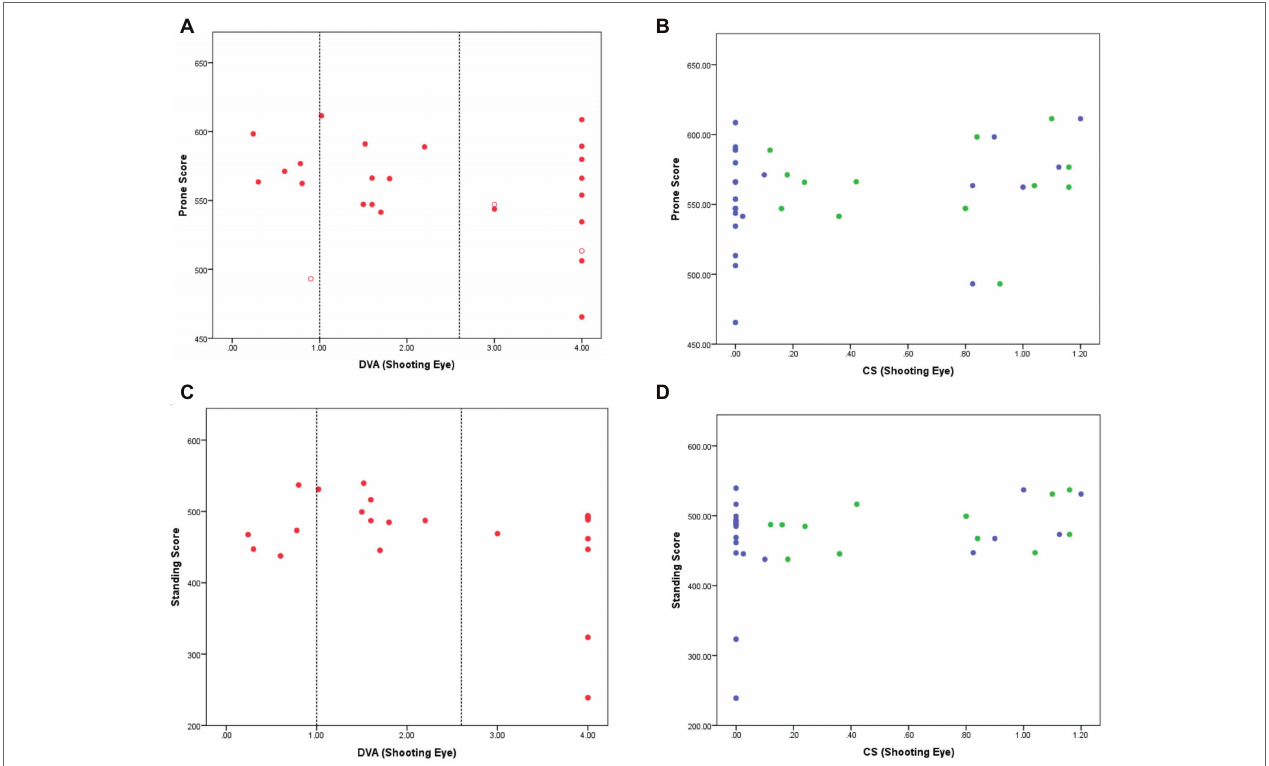
FIGURE 1 | (A–D) Shooting score in the prone (A,B) and standing (C,D) competitions are shown as a function of distance VA ( A and C ; red) and CS ( B and D ; green for Pelli Robson test and blue for Mars test) of the shooting eye. Closed symbols indicate athletes who shot in both prone and standing competitions. Open symbols indicate athletes who shot in the prone competition only. In the VA figures (A,C) , vertical lines indicating 1.0 logMAR (current minimum entry criterion to VI shooting) and 2.6 logMAR [poorest vision measureable with the BRVT; above this level athletes have PL (assigned 3 logMAR) or NPL (assigned 4 logMAR)] are shown. Young adults without VI typically score 0.00 logMAR. In the CS figures (B,D) , participants with no measurable function have a score of 0.00 logCS. Young adults without VI typically score 1.70 logCS